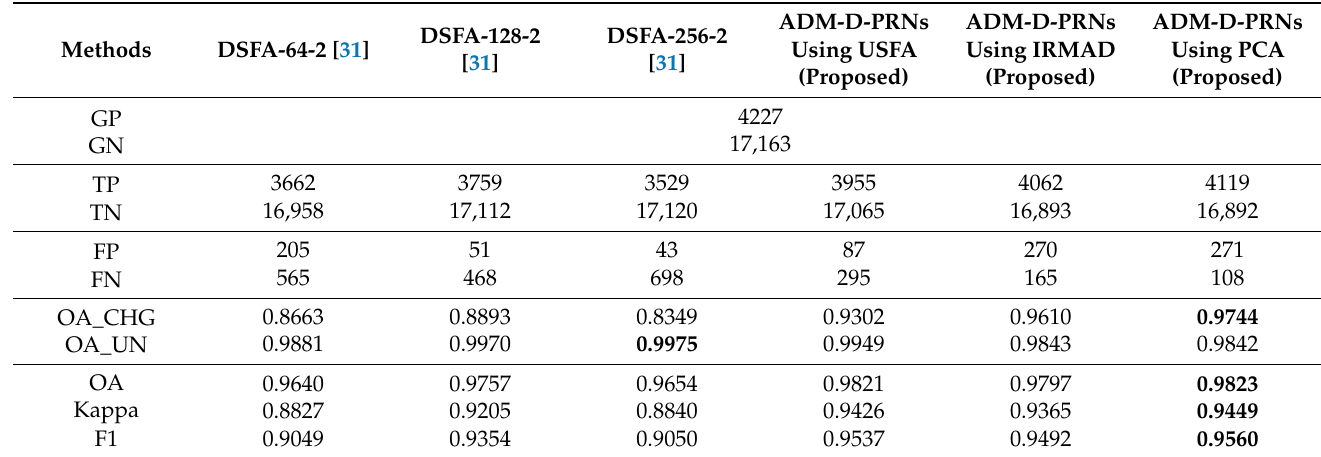
Table 4. Alteration detection results of dataset ‘Taizhou’ using